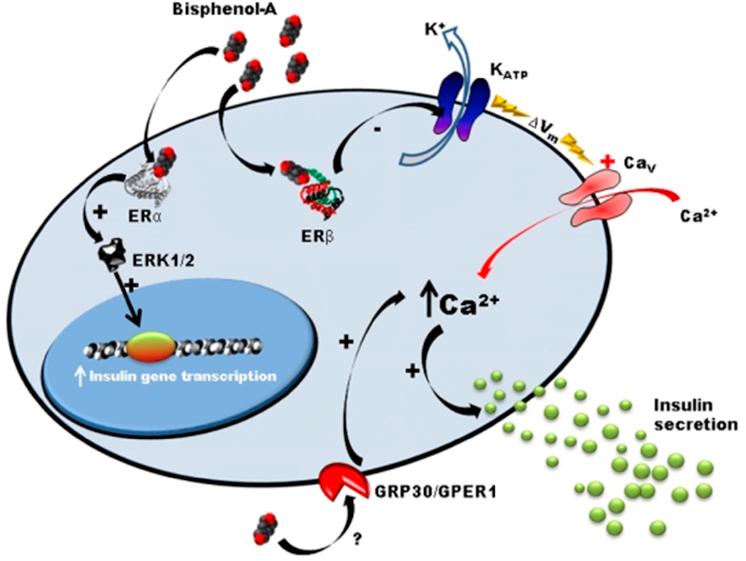
Figure 2. Mode of action of BPA on pancreatic β -cells [37]. This figure reports the mode of action of BPA on pancreatic cells. Low concentrations of BPA interact with Er α , Er β and GPR30 receptors. ER α is involved in the regulation of pancreatic insulin biosynthesis in response to BPA. Er β participates in the insulinotropic effect of BPA on pancreatic β -cells by rapidly decreasing KATP channel activity, enhancing glucose-induced [Ca 2+ ] signals and insulin release. GPR30 is a non-classical membrane estrogen receptor that may participate in the insulinotropic effect of BPA on pancreatic β -cells.